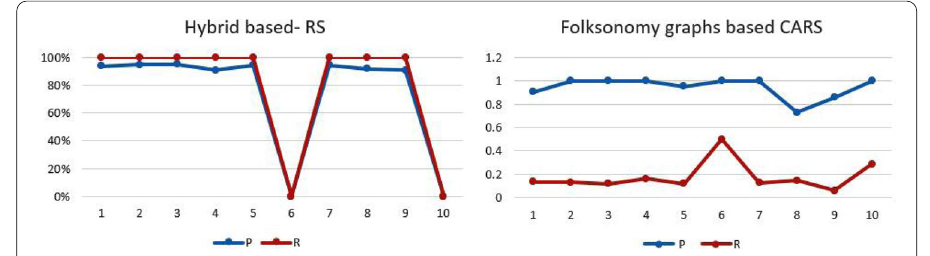
Fig. 5 Precision-Recall